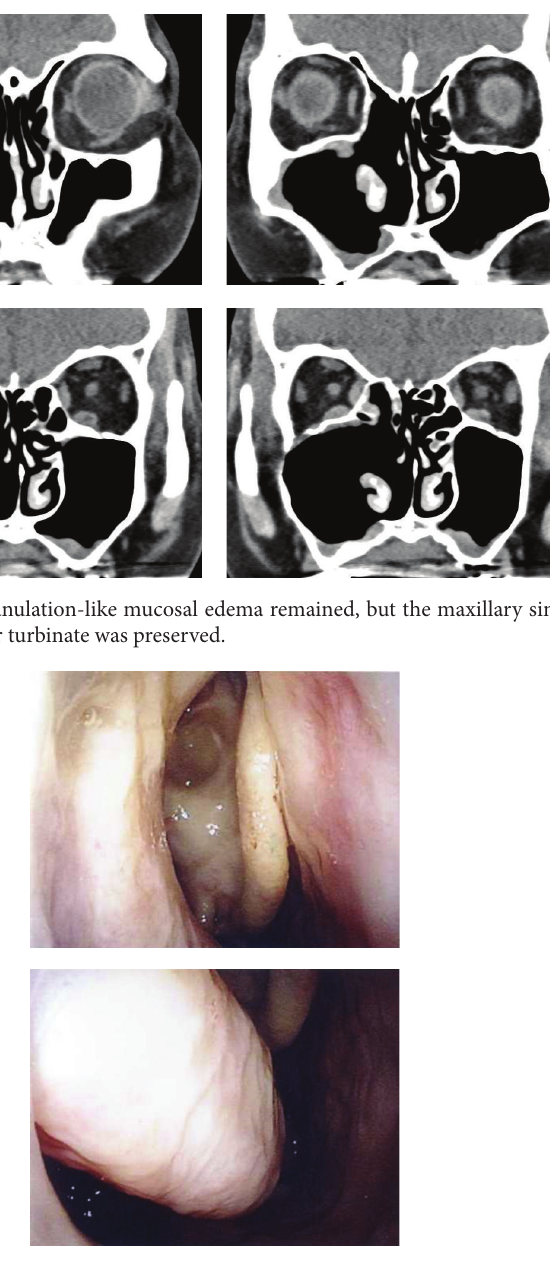
Figure 5: Postoperative observation of nasal cavity. The inferior turbinate was found in its inherent